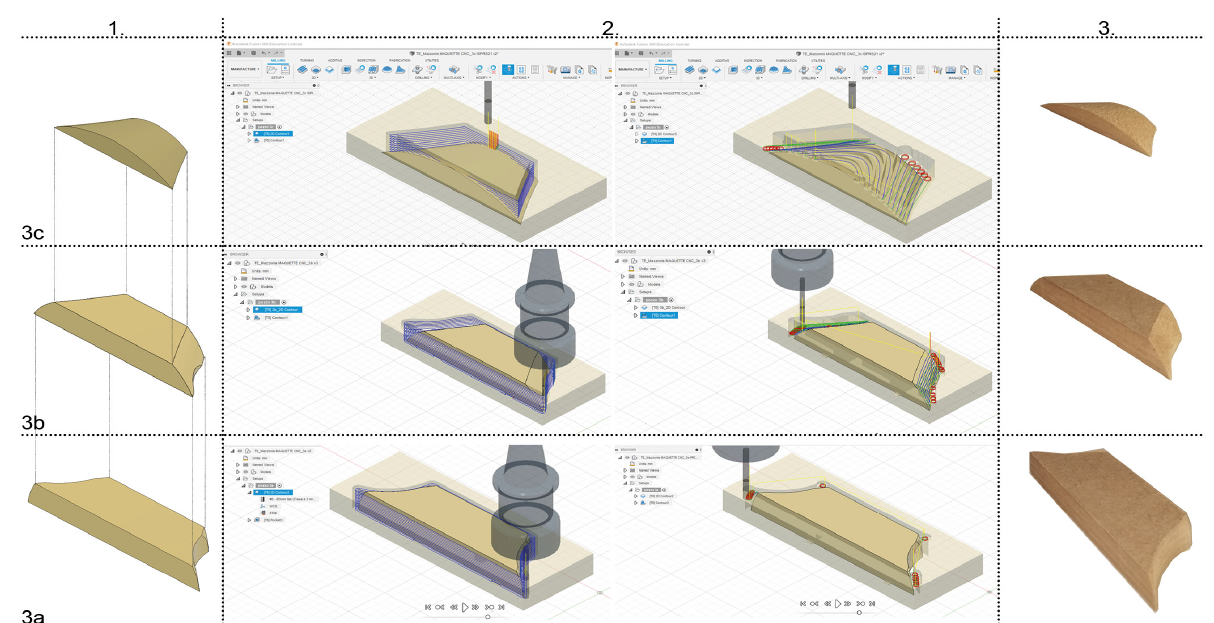
Figure 12 . Working steps for the digital fabrication of the tactile model of the vault of Palazzo Mazzonis atrium. Modeling: F.